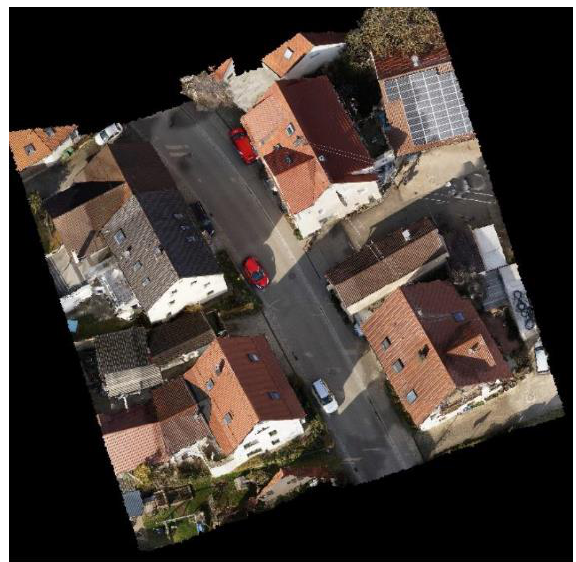
Figure 1 . Overview of the test area (size 50 m × 50 m, approximately 50,000 triangles).